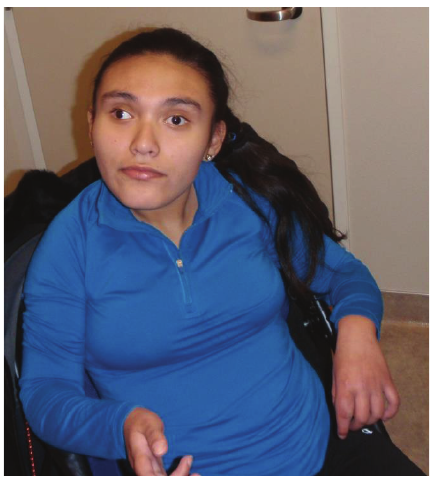
Figure 1: Photograph of the patient at the age of 16.